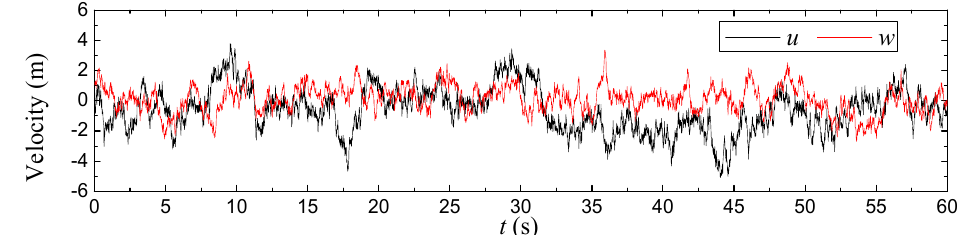
Figure 16. Sample of turbulent wind velocity obtained by the described procedure (U = 10 m/s).